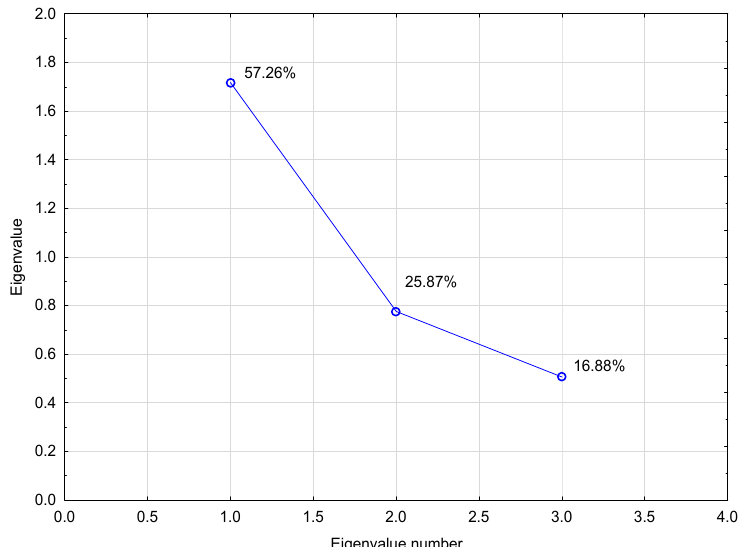
Figure A3. Eigenvalues of correlation matrix.